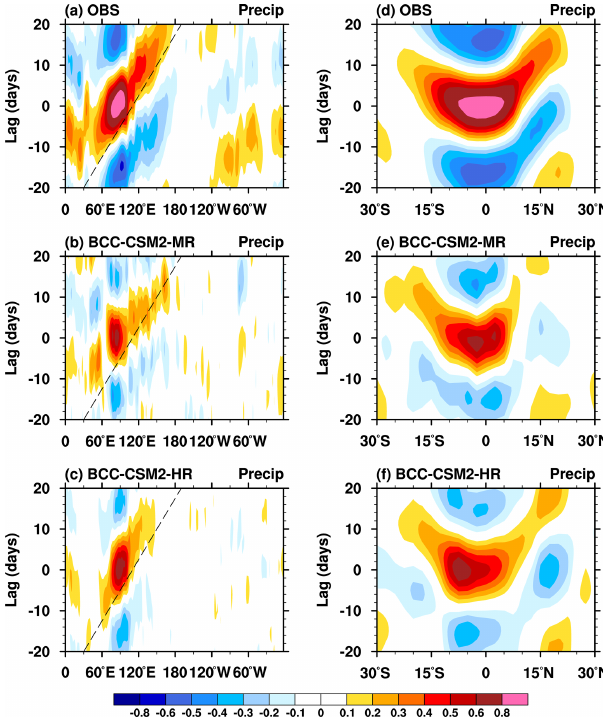
Figure 16. (a, b, c) Longitude–time evolution of lagged corre- lation coefficient for the 20–100d band-pass-filtered precipitation anomaly (averaged over 10 ◦ S–10 ◦ N) against regionally averaged precipitation over the equatorial eastern Indian Ocean (80–100 ◦ E, 10 ◦ S–10 ◦ N). (c, d, e) Same as the left panels, but for the latitude– time evolution of lagged correlation coefficients for filtered precip- itation anomaly (averaged over 80–100 ◦ E) against the regionally averaged precipitation over the equatorial eastern Indian Ocean. Dashed lines in each panel denote the 5ms − 1 eastward propaga- tion speed. The observations in (a) and (b) are derived from GPCP data and the simulations are from (c, d) BCC-CSM2-MR, and (e, f) BCC-CSM2-HR for the period from 1995 to 2014.